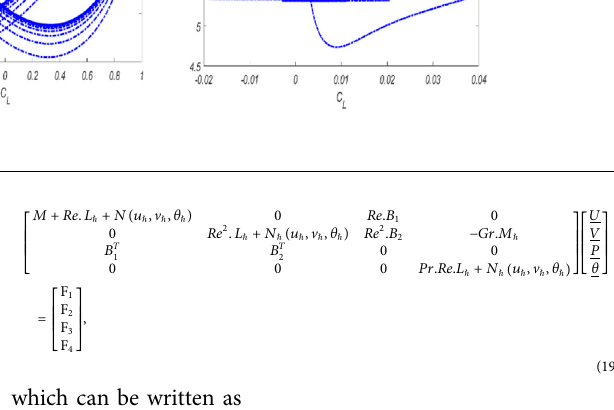
FIGURE 7 | Impact of n on the phase plot ( C